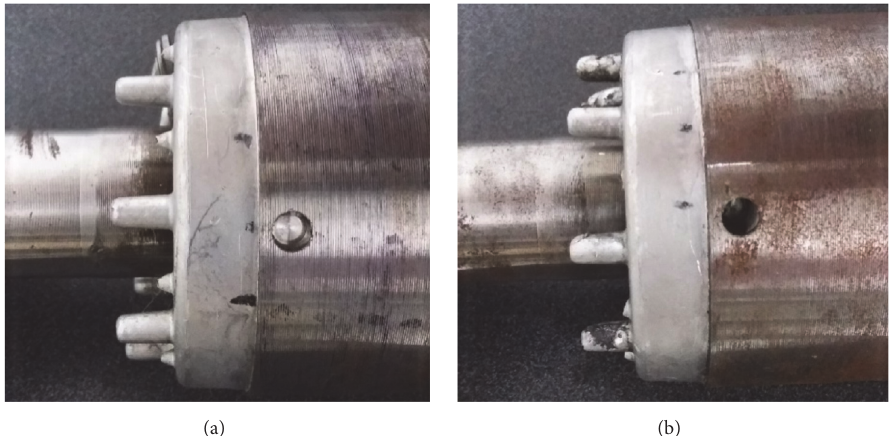
Figure 4: Detail of the faults produced in the test bench. (a) corresponds to the 1/2 broken rotor bar and (b) to one broken rotor bar.